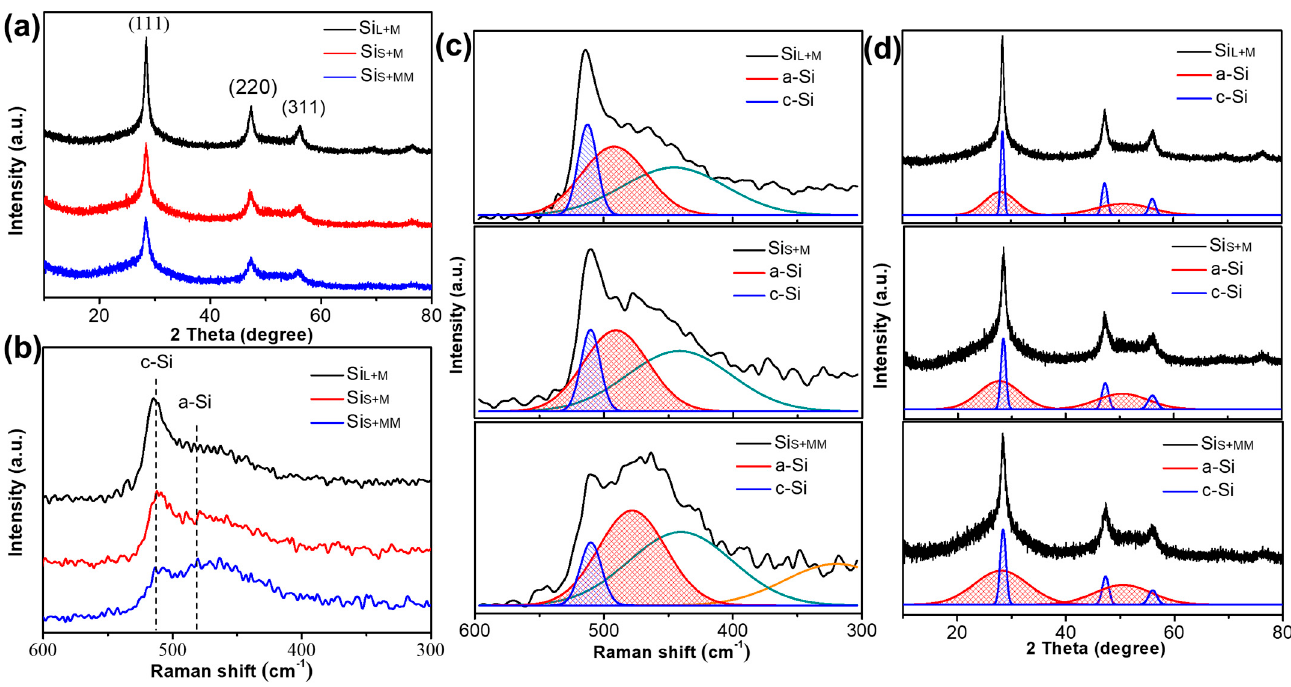
Figure 10. ( a ) X-ray diffraction patterns, ( b ) Raman spectrum, ( c ) Raman spectrum fitting and ( d ) XRD pattern fitting of Si L+M , Si S+M and Si S+MM .